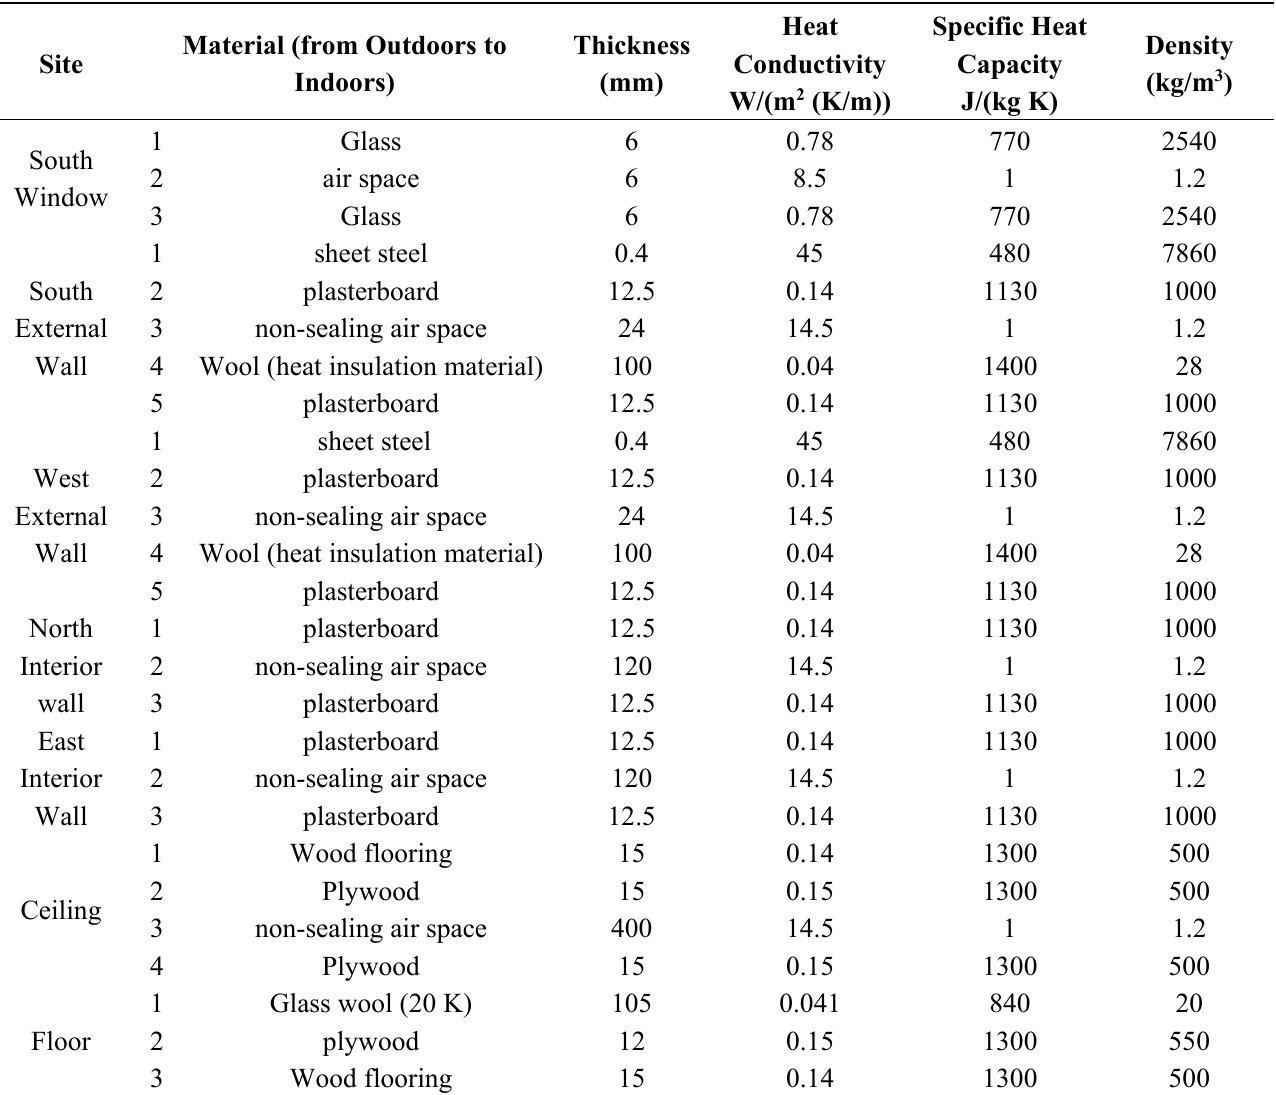
Table A2. Data of the building envelope